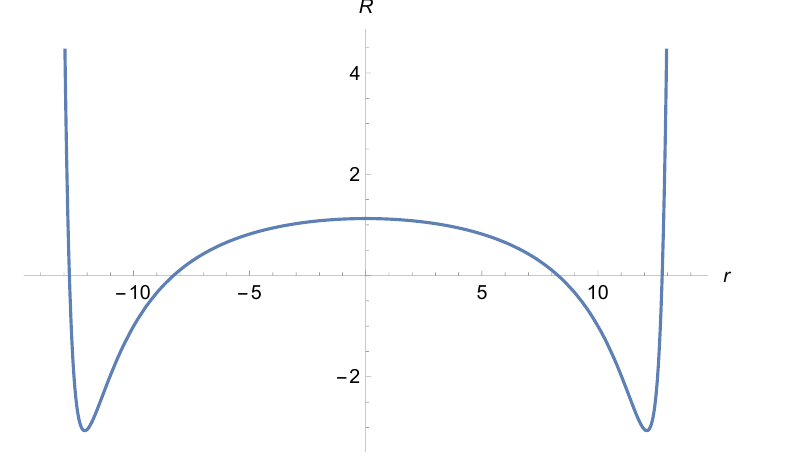
Figure 3 . Ricci scalar curvature for G = 2 , c = 0 . 1 , r A = 1